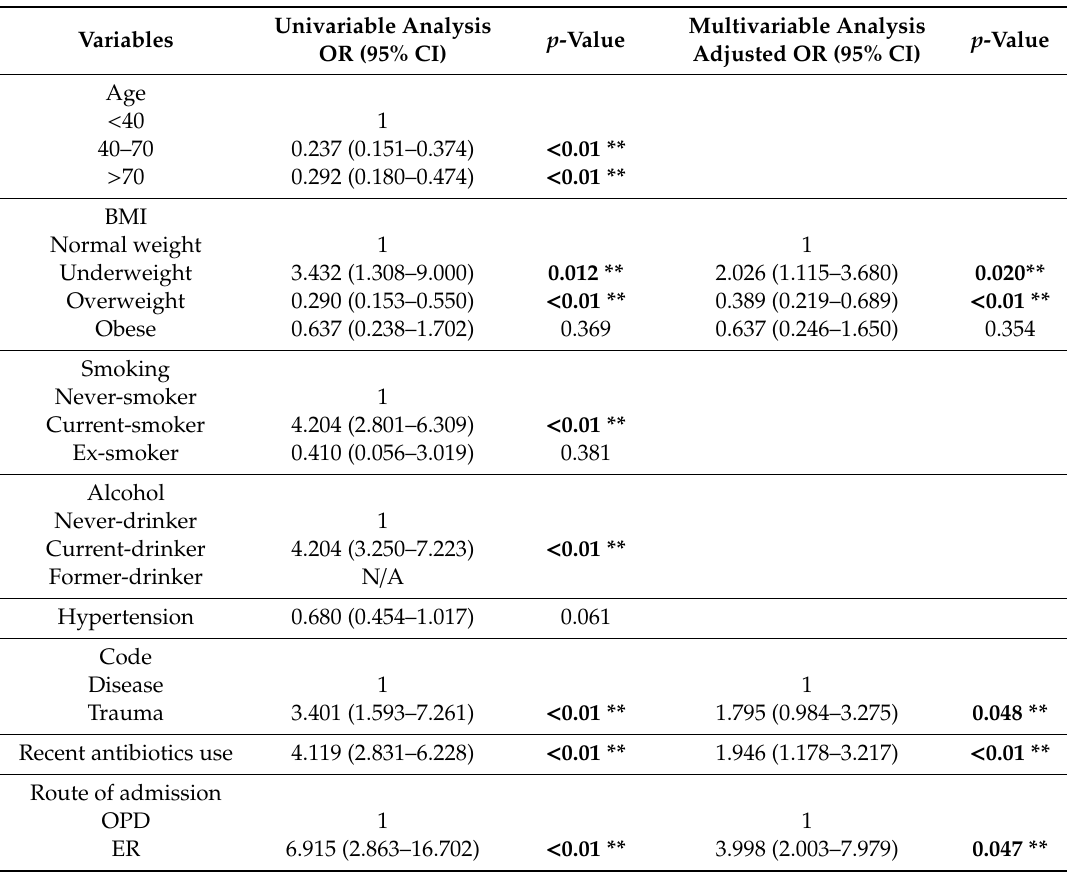
Table 4. Univariable and multivariable logistic regression analysis of the risk factors associated with MRSA